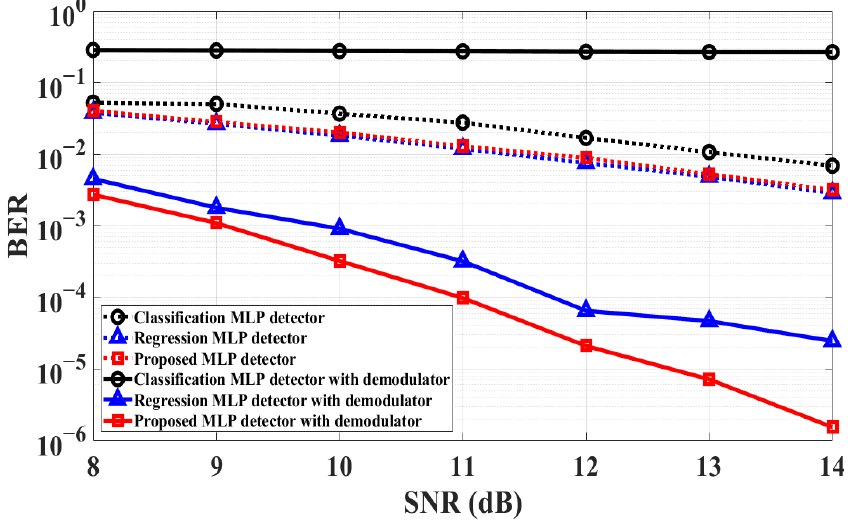
Figure 8. BER performance of detectors and demodulators according to MLP detectors.